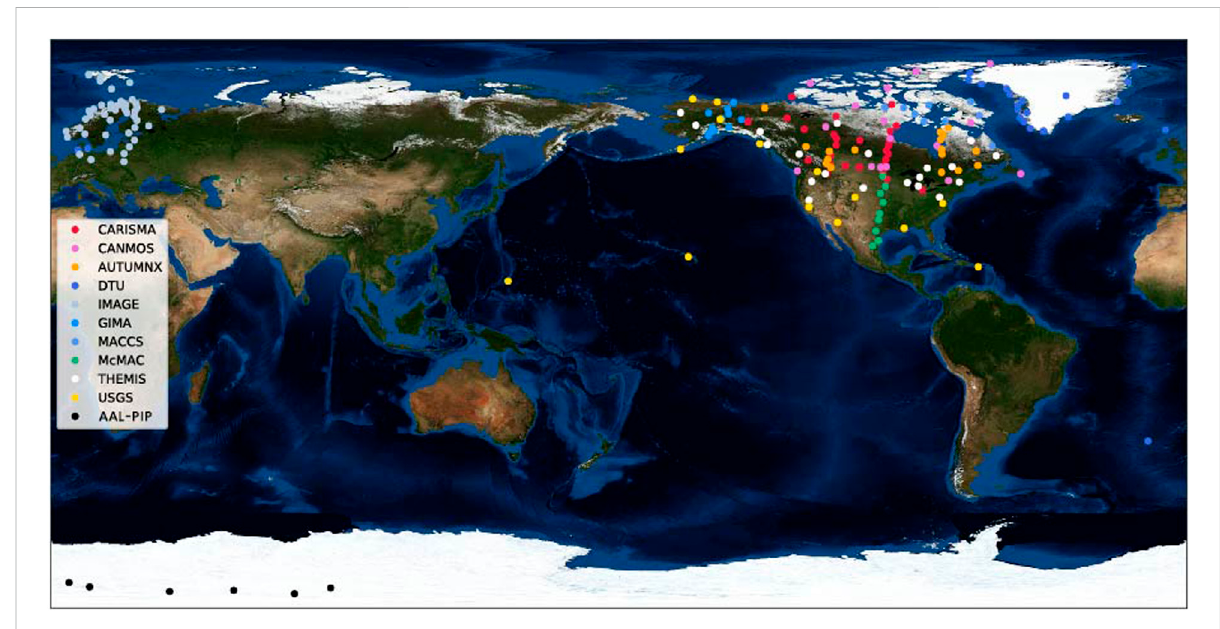
FIGURE 1 The geographic location of ground-based magnetometers that the GMAG package can download and load data for. The stations are color coded by their parent array (see legend and Table 1).